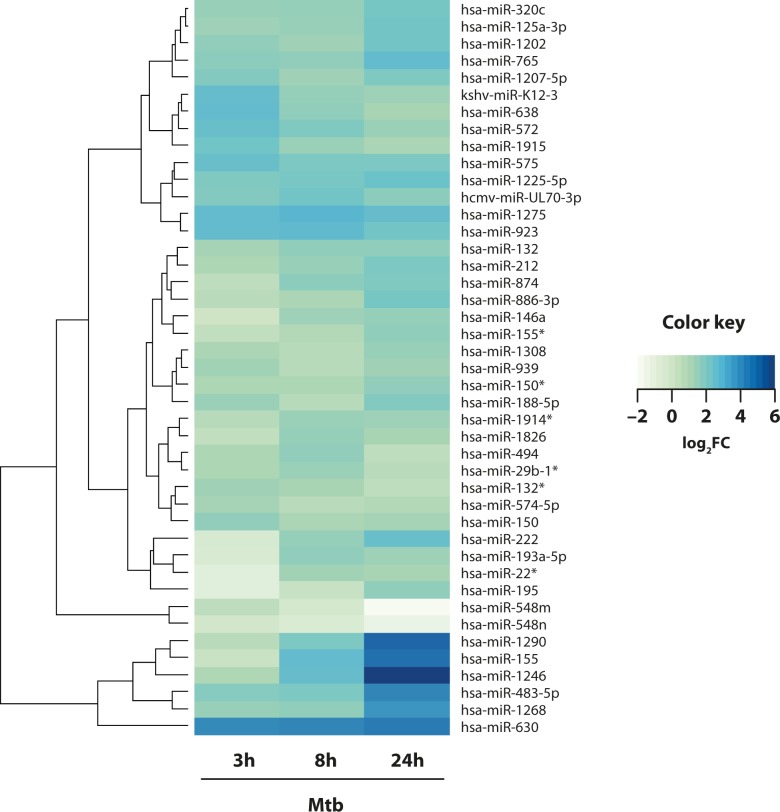
Identification of miRNAs altered in human DC during Mtb infection.DC were infected with Mtb for 3, 8 and 24 hours. Heatmap shows the significantly regulated miRNAs (FDR <0.05) during infection, in terms of log2 fold changes in the comparison Mtb-infected DC vs. untreated cells. Each row represents a single miRNA, averaged across different probes if significantly regulated (see Table 1), and each column a different time point, as indicated. The log2 fold change in the comparison Mtb-infected DC vs. CTRL are represented by a color code according to the legend. The dendrogram clusters together the significantly regulated miRNAs with most similar expression profiles.